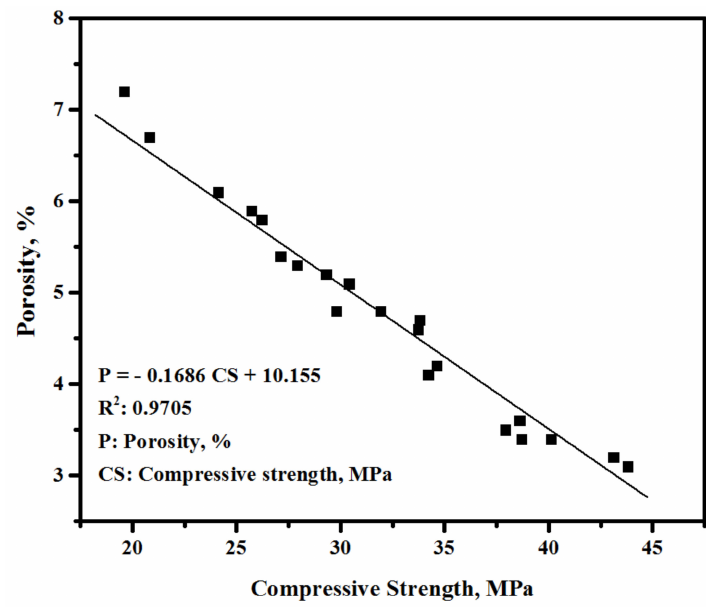
Figure 8. Porosity as a function of CS of bio-concretes at 7, 28 and 56 days of curing age.